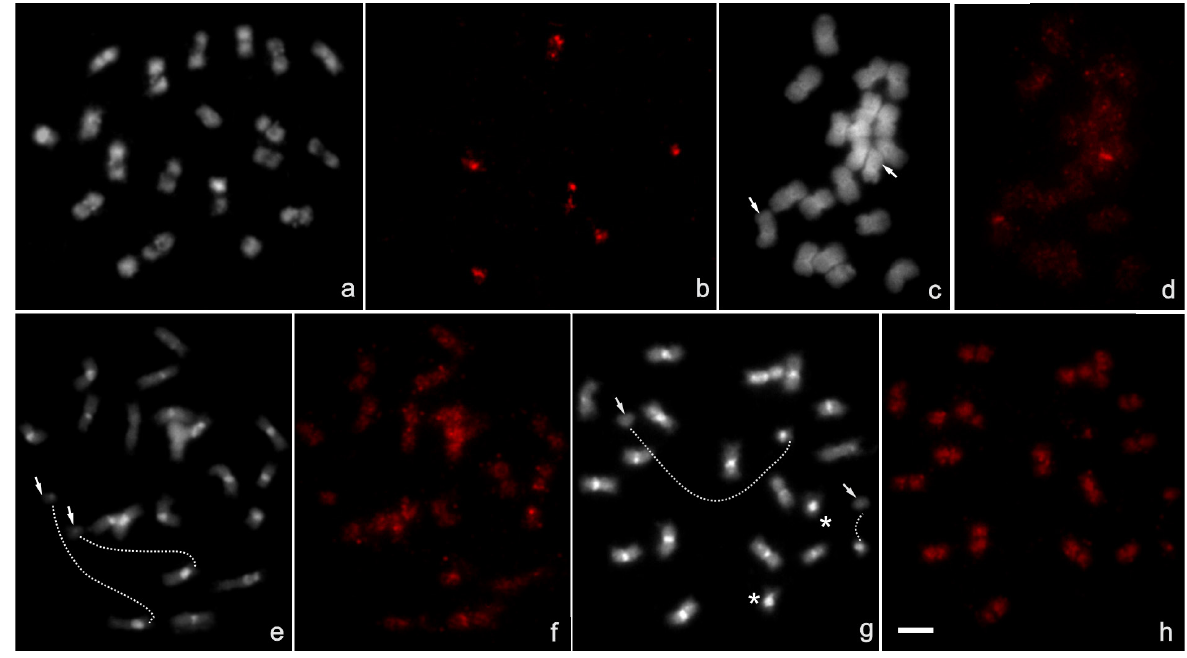
Figure 1. Representative somatic metaphases of diploid Arachis species of the sections Heteranthae , Rhizomatosae and Arachis after single GISH experiments using gDNA probe from A. glabrata (red) and DAPI staining (gray): (a, b) A. pusilla , (c, d) A. burkartii , (e, f) A. batizocoi , (g, h) A. duranensis . The white arrows point to the satellites, which are attached with dotted lines to the proximal regions of their respective chromosomal arms. Pair A9 of A. duranensis is indicated by asterisks in Figure 1g. Scale bar = 3